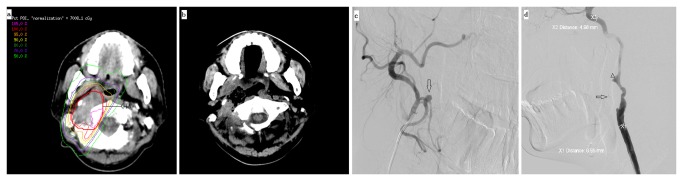
One patient who had haemorraghe after reirradiation: (a) showed the treatment plan for a patient with recurrent foci invading the poststyloid space and so on, (b) showed the CT scan four months after IMRT of the necrosis of nasopharyngeal mucose, and a cavity continuing from the pharynx was formed after the tissue was expelled, (c) the patient had several attack of haemorraghe, DSA showed the right lingual artery pseudoaneurysm (arrow) five months after IMRT, (d) the patient again had massive haemorraghe six months after IMRT, DSA showed pseudoaneurysm in right internal carotid artery (arrow head), coil (arrow) placed at the lingual artery level for (c).